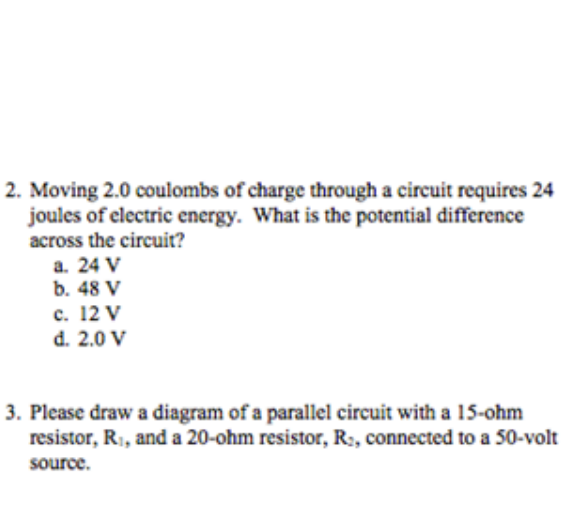
Figure 2. Pre-quiz given to the students before